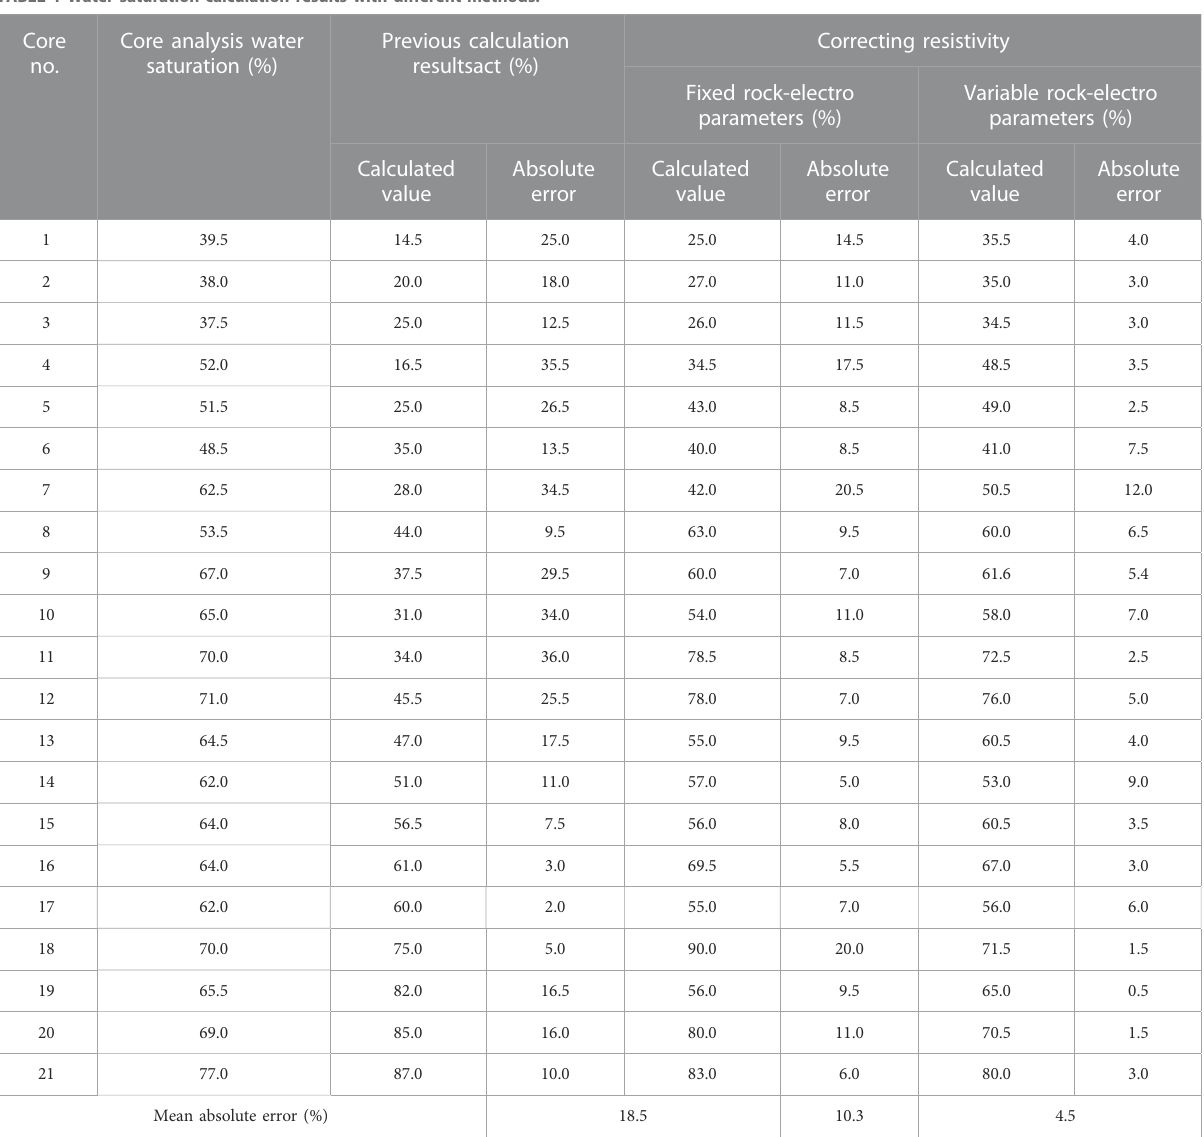
TABLE 1 Water saturation calculation results with different methods. Core Core analysis water no. saturation